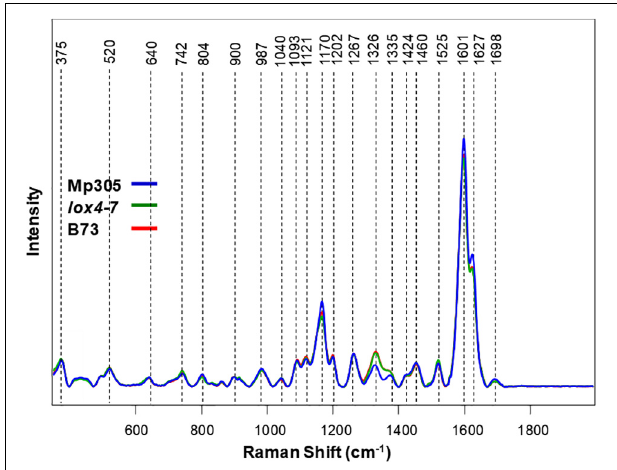
FIGURE 4 | Raman spectra collected from stalks of non-inoculated control plants from all three maize varieties.